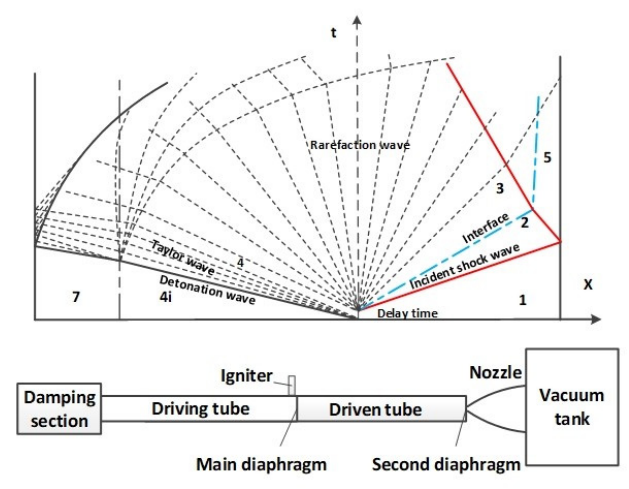
Figure 3. Schematic diagram of the high-enthalpy shock tunnel facility.